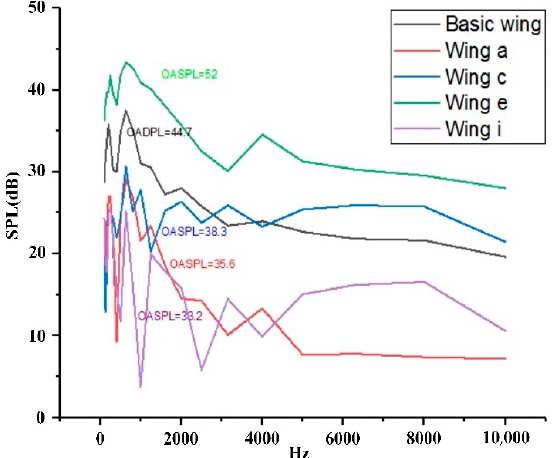
Figure 5. 1/3 octave sound pressure level versus different frequency.